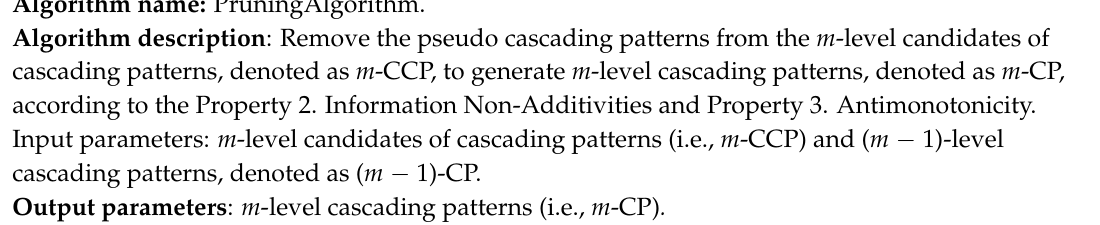
Algorithm 3. Pruning algorithm to remove the pseudo cascading patterns. Algorithm name: